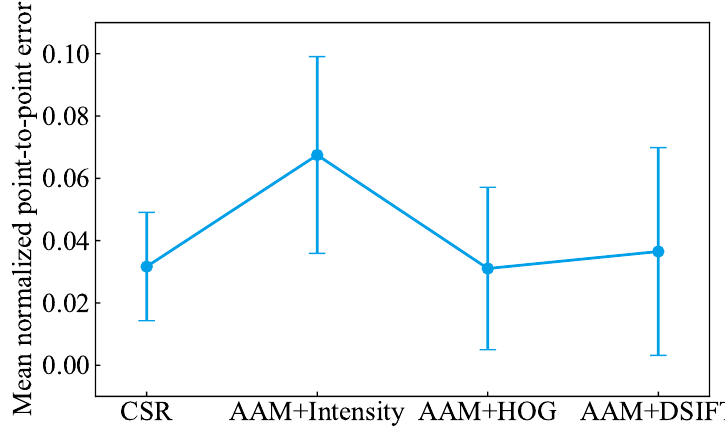
Figure 7. The mean value of NPPE of the test images for each method. Error bars represent standard